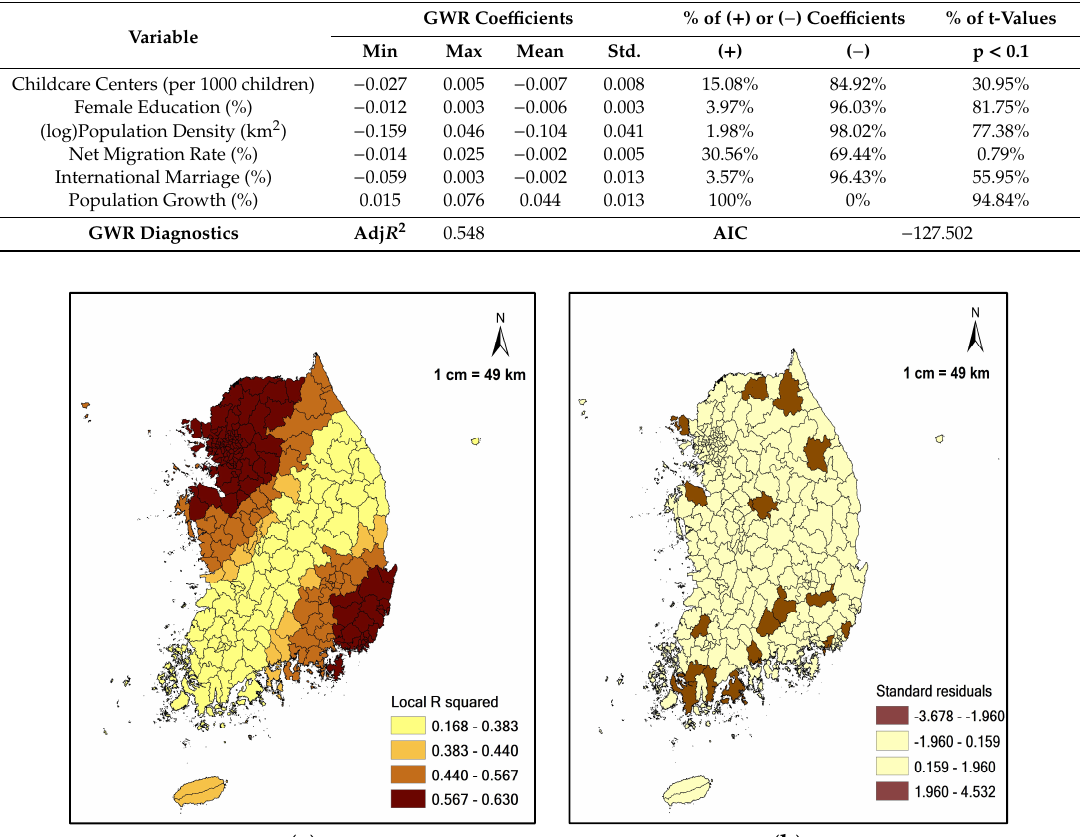
Figure 3. ( a ) R-squared values; ( b ) standard deviation of residuals.